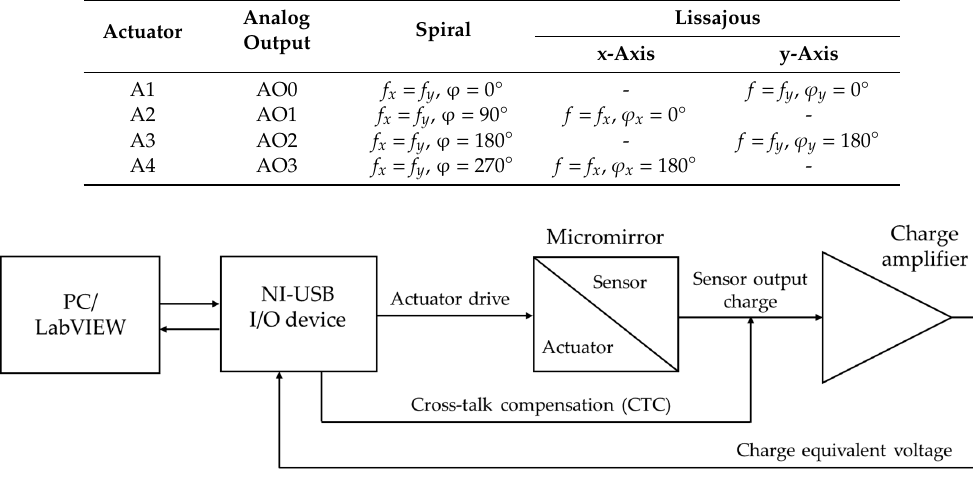
Figure 13. Schematic of the sensor signal evaluation setup [10].